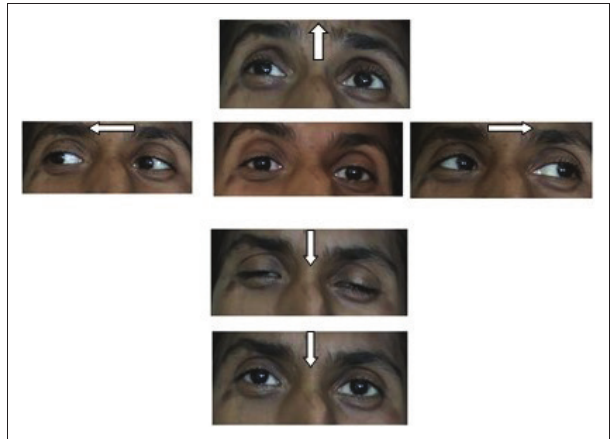
FIGURE 1: Testing of ocular movements showing full range of horizontal gaze but limited vertical gaze. Downgaze is affected more than upgaze. The arrows show the direction of gaze instructed by the examiner. Downward gaze is shown in the bottom two pictures: the first shows her attempting downgaze and the second shows the limitation.